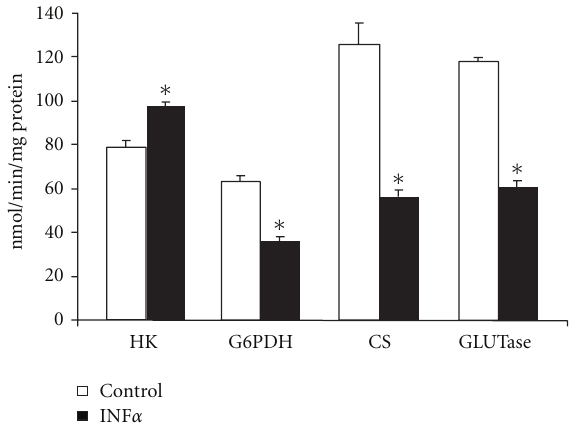
Figure 3: Maximal activity of enzymes of lymphocytes from spleen cultured in the presence or absence of IFN α . The results are expressed as nmol/min per mg of protein and represent the mean ± SEM of 9 experiments. HK: hexokinase; G6PDH: glucose-6-phosphate dehydrogenase; CS: citrate synthase; GLUTase: phosphate dependent glutaminase. ∗ P < . 05 for comparison with the control (C) group.